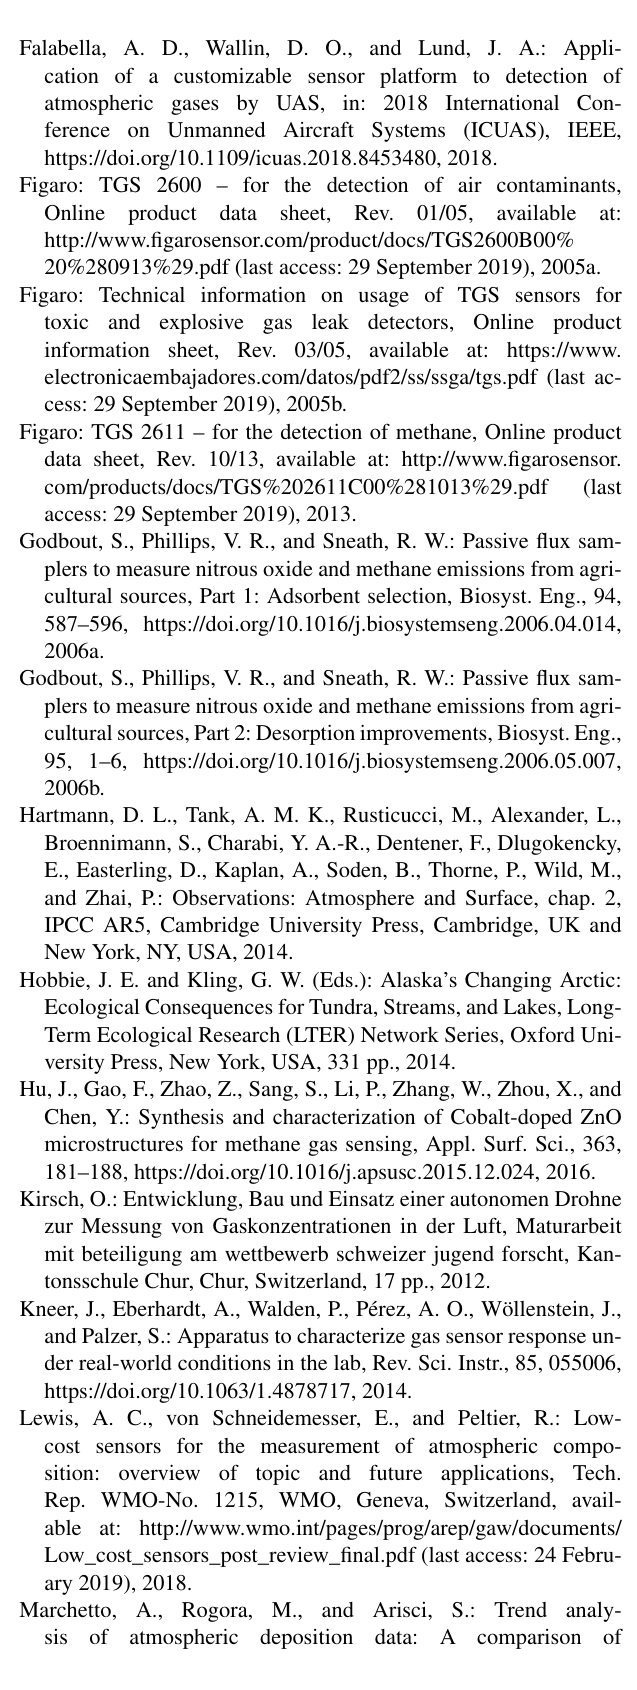
Figaro: TGS 2600 – for the detection of air contaminants, Online product data sheet, Rev. 01/05, available at: